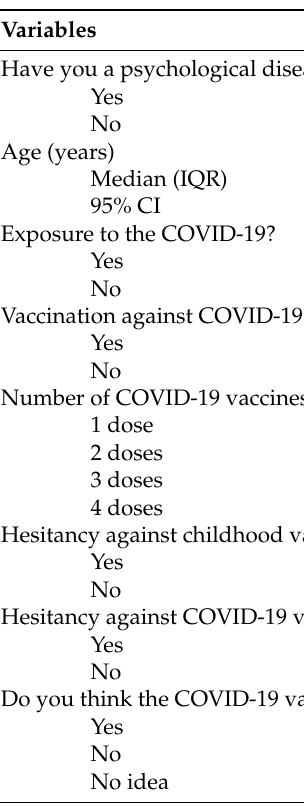
Table 2. Distribution of various variables of participants related to COVID-19 and